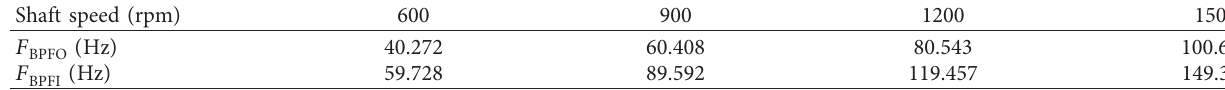
Table 4: Frequencies of the bearing in different speeds.